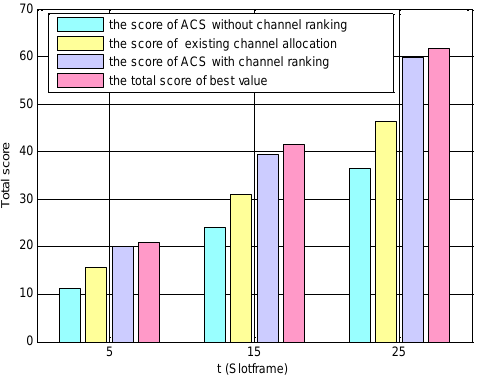
Figure 9. Score under different channel allocation algorithms.